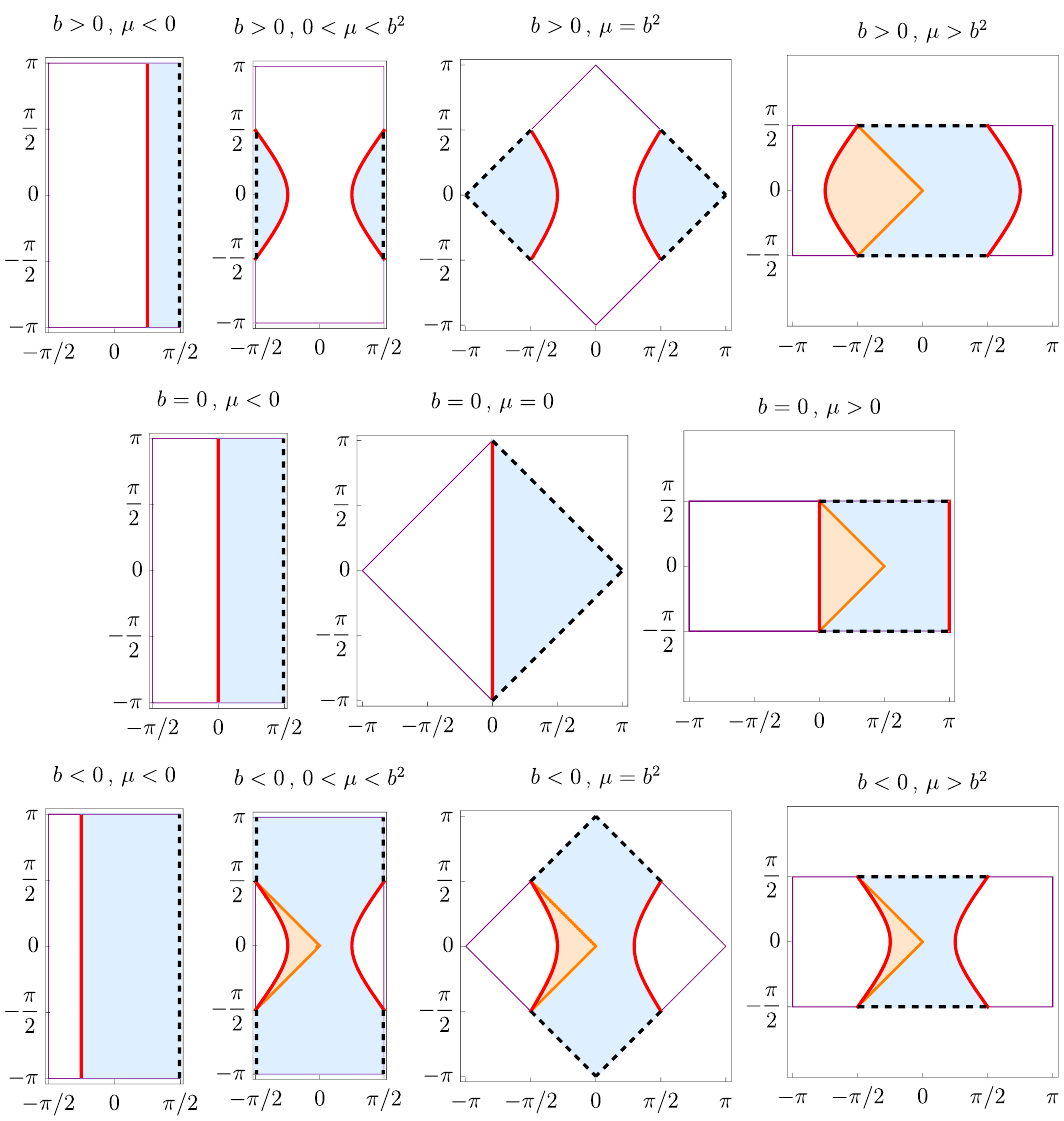
Figure 3: Conformal diagrams for the physical spacetimes with metric g = X − 2 ˆ g . The shaded region is a representation of X > 0 on the full conformal diagram of dS , Minkowski , or AdS . The region normally covered by the appropriate global 2 2 2 coordinates is indicated by a purple outline. The conformal boundary X = 0 is shown as a bold dashed black line, while X → ∞ is shown as a bold red curve. One of the two horizon wedges associated with Schwarzschild-type coordinates is shaded